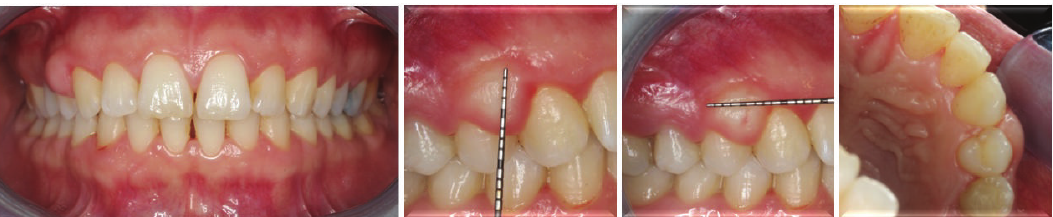
Figure 1: Clinical appearance of the whole mouth and lesion.